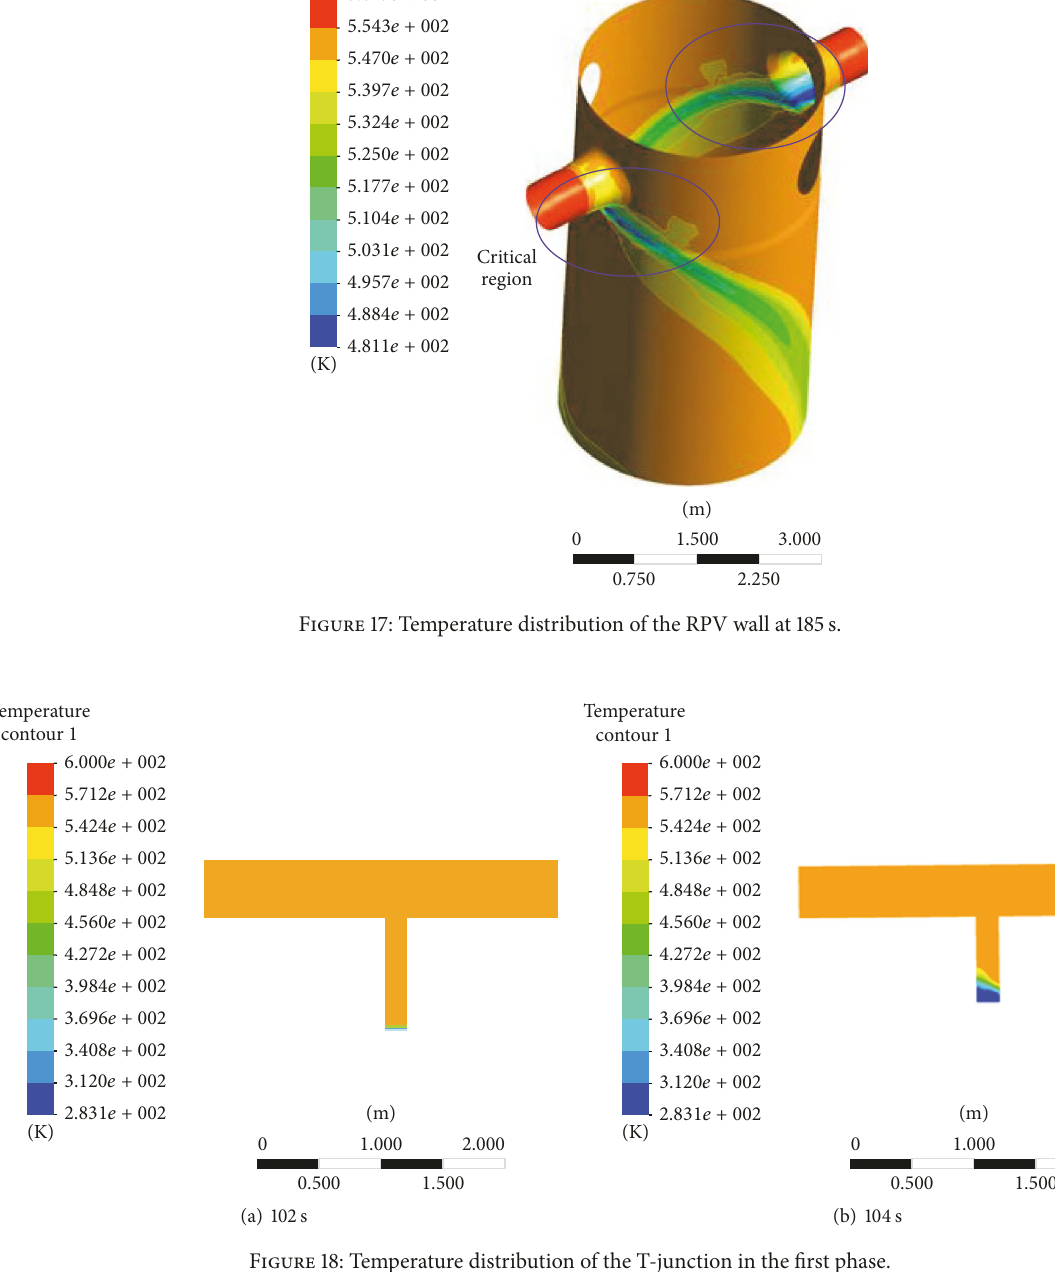
Figure 18: Temperature distribution of the T-junction in the first